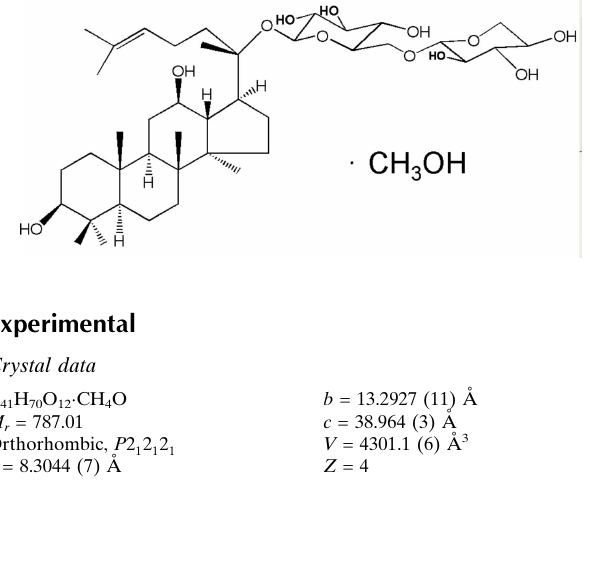
Related literature For general background, see: He et al. (2005); Hu et al. (2007). For related literature, see: Li et al. (2006).